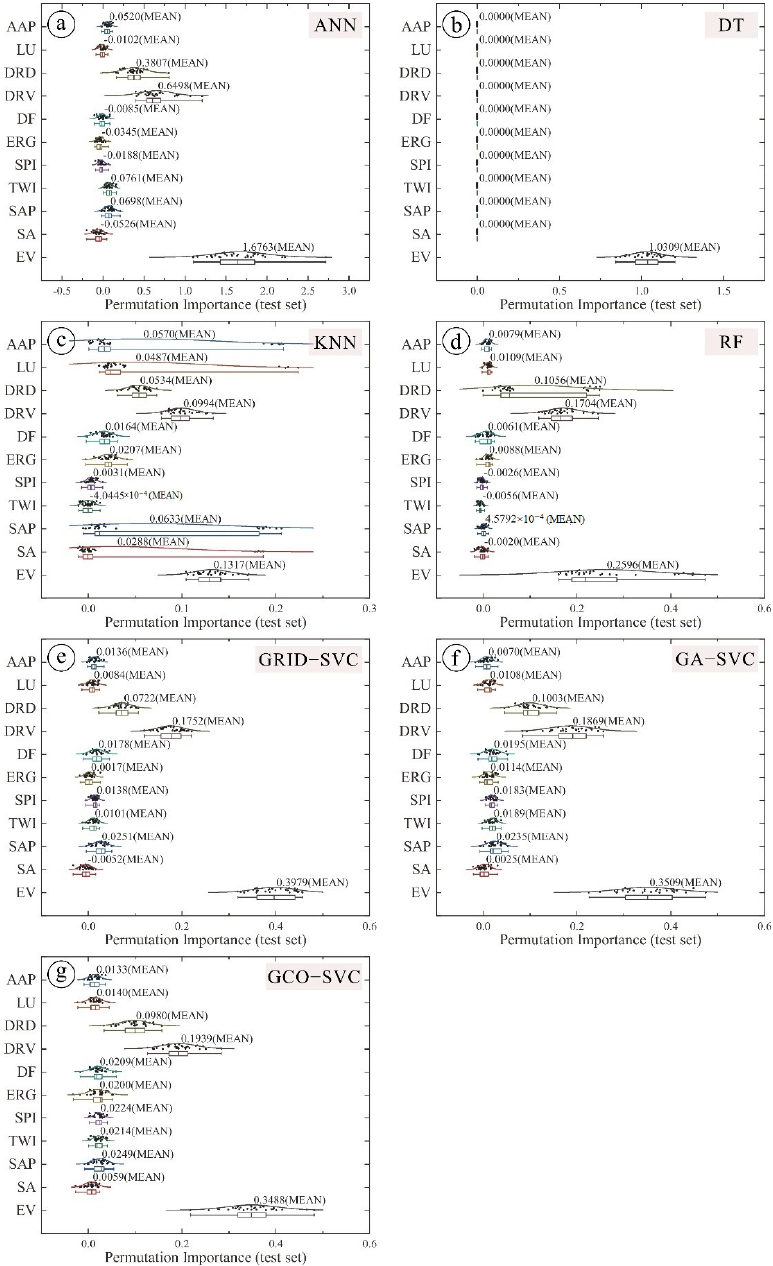
Figure 9. PFI scores of landslide influencing factors for the seven models (randomly shuffled 30 times), includes ( a ) ANN, ( b ) DT, ( c ) KNN, ( d ) RF, ( e ) GRID-SVC, ( f ) GA-SVC, and ( g )